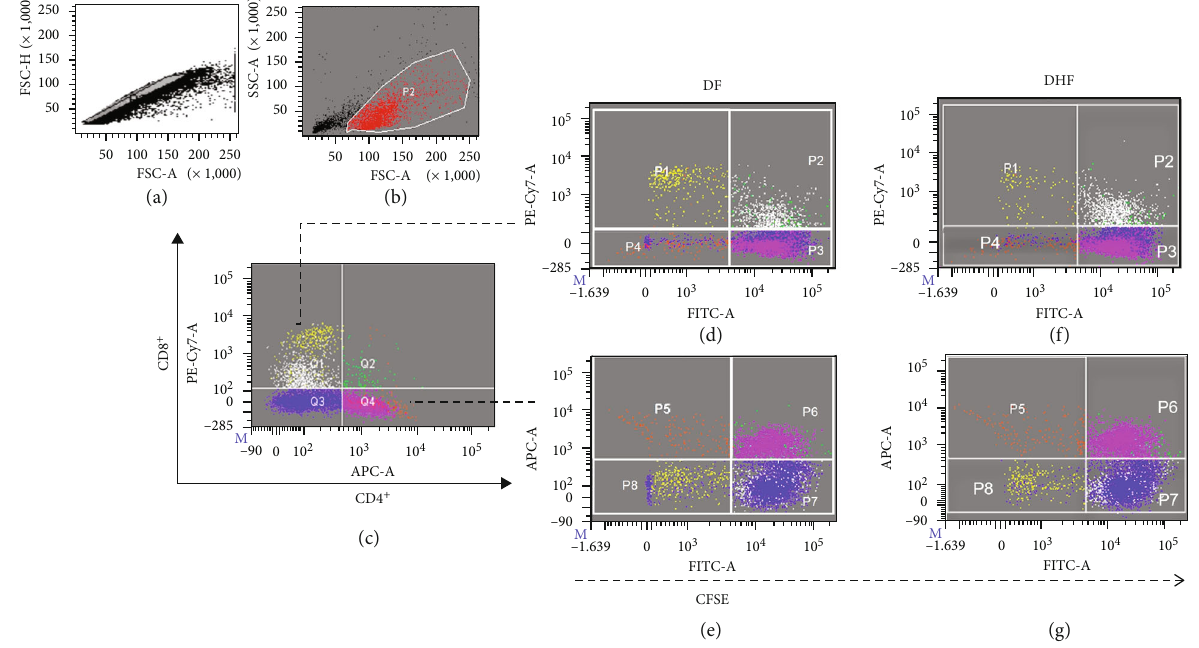
Figure 5: Strategy for the analysis of proliferating T cells labelled with CFSE. Singlets and live cells were selected (a, b). CD4 + and CD8 + positive cells were de fi ned with APC or PE-Cy7, respectively (c). Representative plots show CD8 + and CD4 + cells in (d, e) DF and (f, g) DHF patients; P1 and P5 represent CD8 + and CD4 + proliferating cells (low CFSE), respectively. These data in cells stimulated with dengue virus peptides are shown in Figure 6. P2 and P6 represent CD8 + and CD4 + nonproliferating cells (high CFSE),